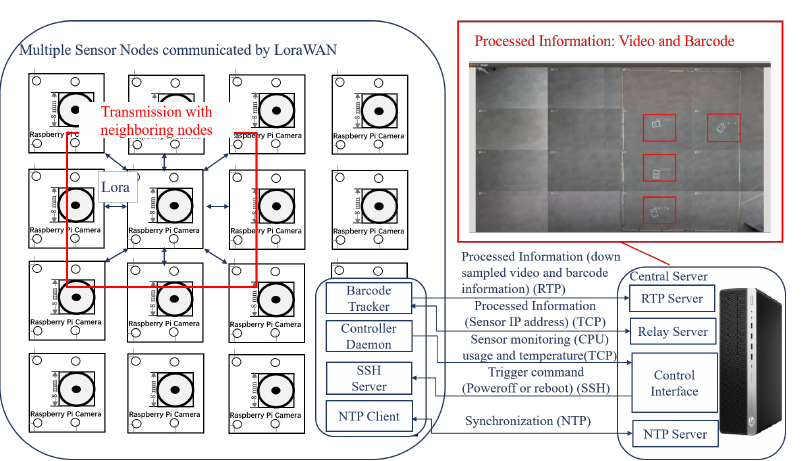
Figure 2. Overview of the distributed VSN system:16 Raspberry-pi cameras connected via LoRa, cameras and a central server is connected via RTP, TCP, SSH, and